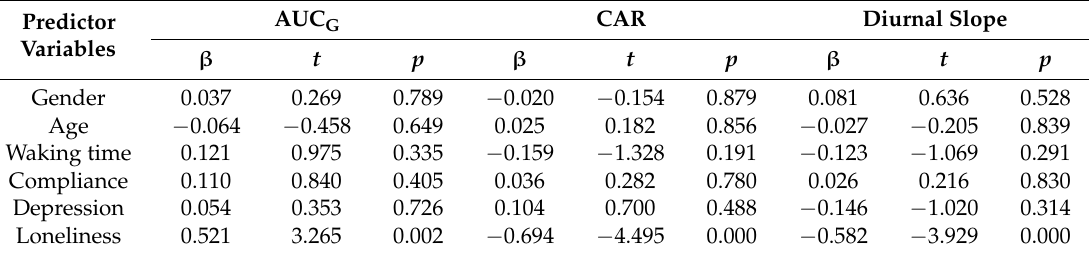
Table 3. Linear regression model predicting the three cortisol indices.